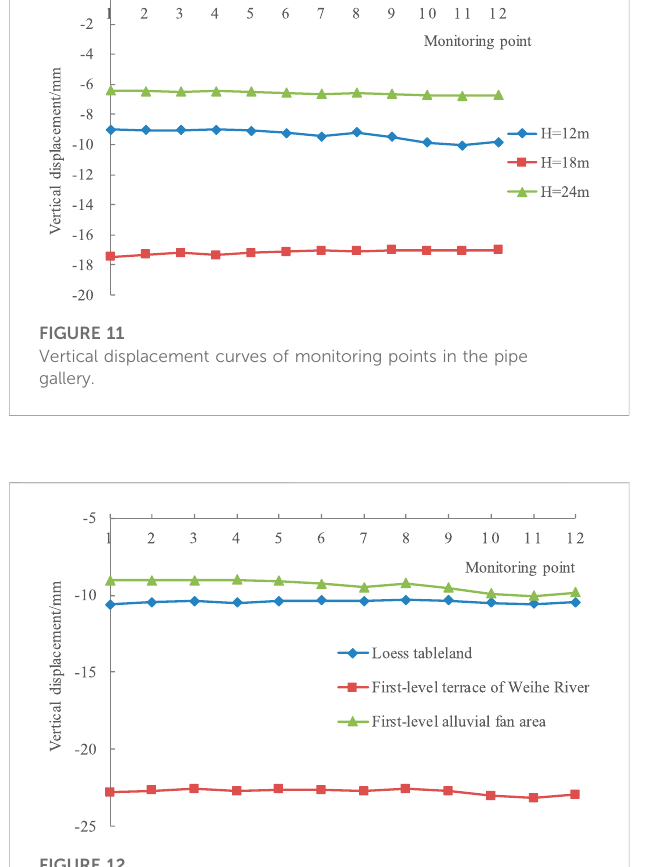
FIGURE 12 Vertical displacement curves under a 12 m tunnel buried depth.